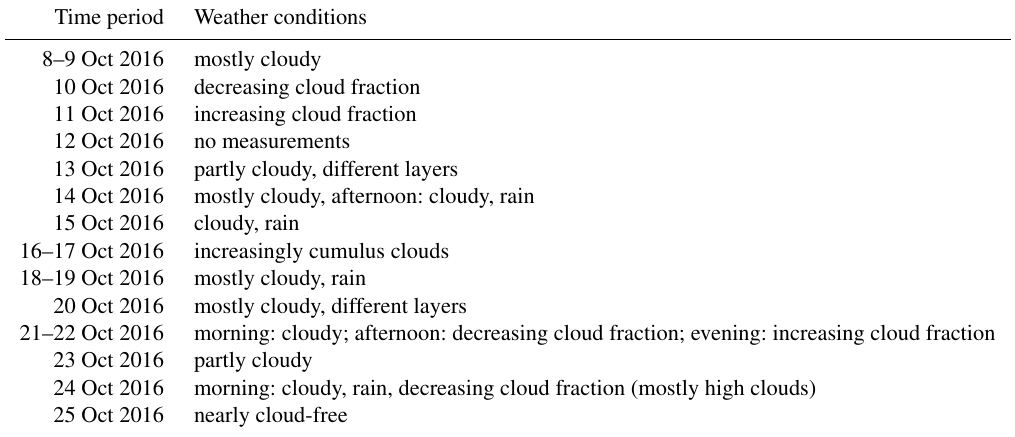
Table 1. Weather and viewing conditions during COPMAR.